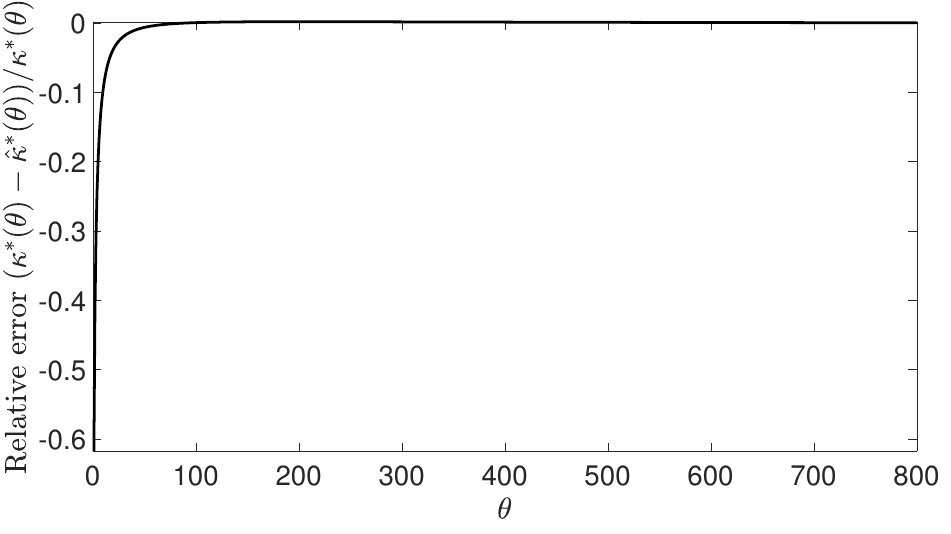
Figure 6. Plot of relative error between κ ∗ ( θ ) and ˆ κ ∗ ( θ ) vs. θ . Table 1. The κ ∗ ( θ ) , ˆ κ ∗ ( θ ) , and relative error between κ ∗ ( θ ) and ˆ κ ∗ ( θ )